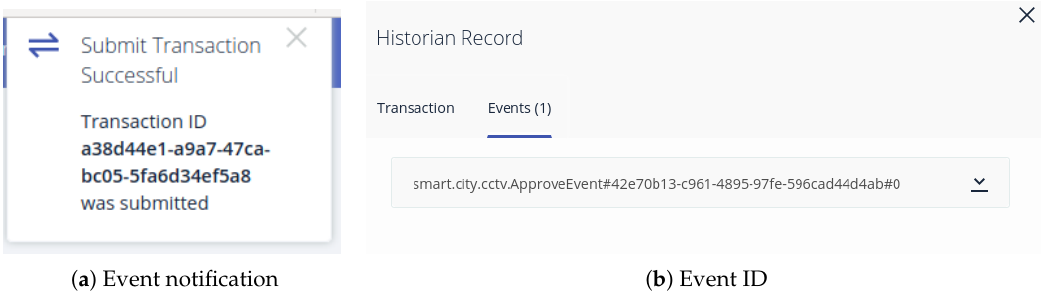
Figure 11. Notification upon successful transaction submission.